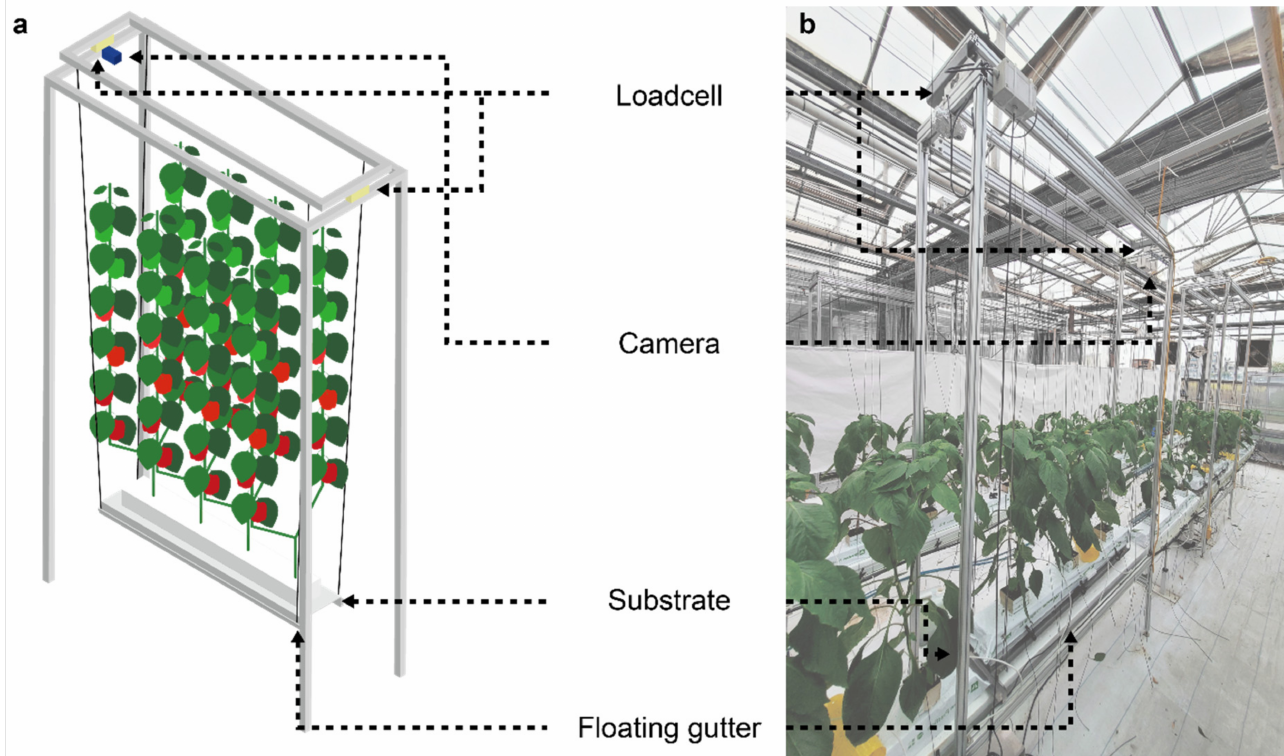
Figure 2. Structure of the monitoring system. ( a ) Mimetic diagram; ( b ) photograph of the real device. A substrate moisture sensor was directly installed upon a floating gutter, minimizing